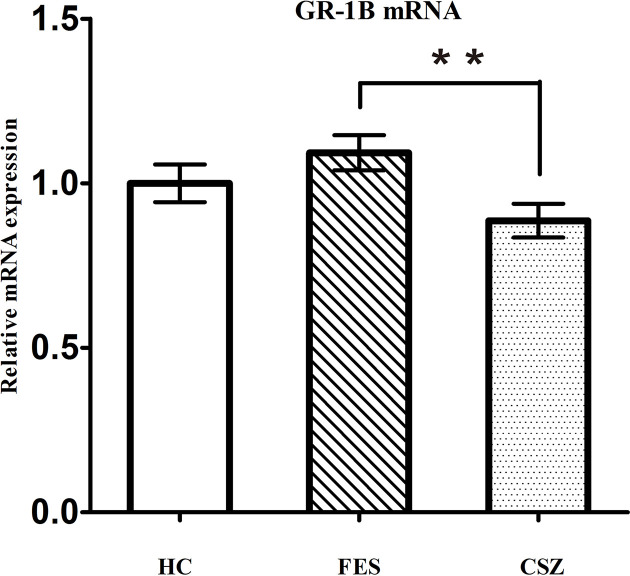
Representative of the relative mRNA expression of GR 1B gene. ** means P < 0.01. Error bars denote mean and SD. FES, first-episode schizophrenia; CSZ, chronic schizophrenia; HC, healthy controls; GR 1B, GR transcripts containing exons 1B.